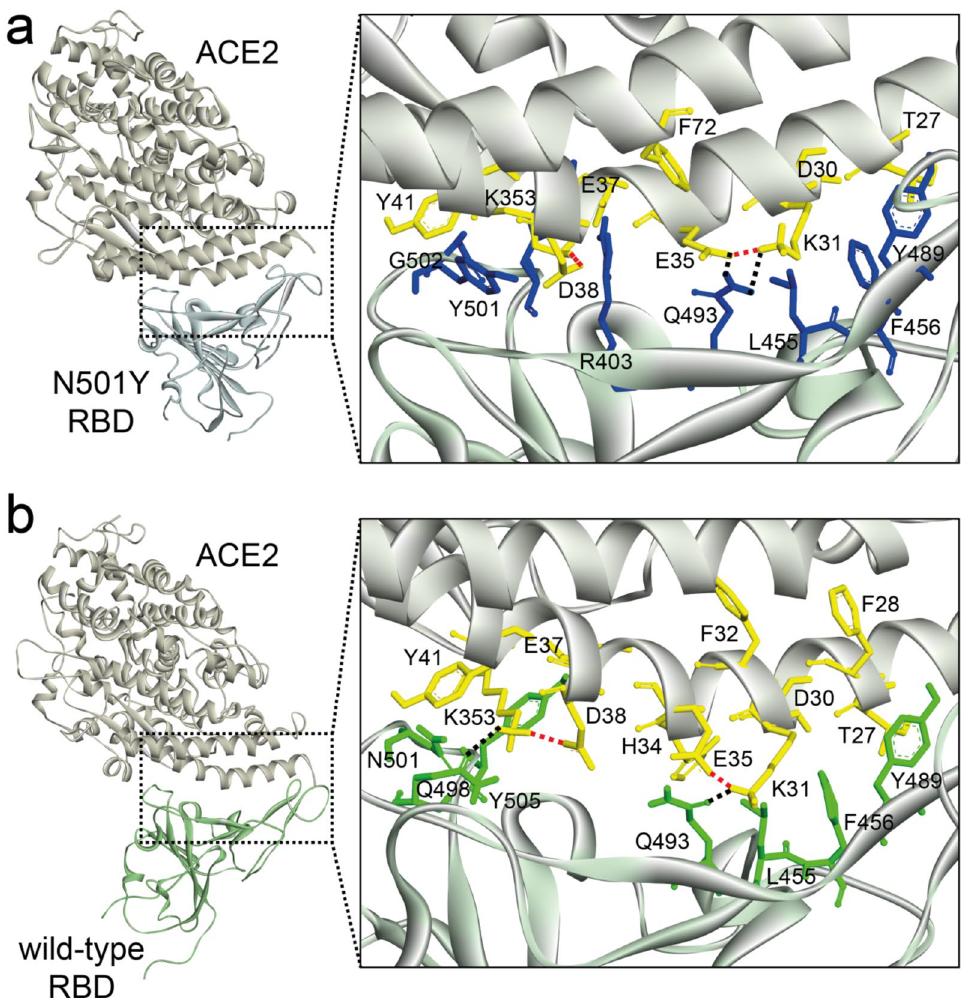
Figure 4. Structural mapping of the binding interface structure of ( a ) N501Y, and ( b ) wild-type complex with ACE2. The structure of RBD is shown in light-yellow ribbon, while ACE2 is in green (wild-type) and pastel- blue (N501Y) ribbon. The close-up of these binding complexes is shown the crucial mutations responsible for high binding interaction (right panel). The interfacial residues of SARS-CoV-2 RBD residues are annotated and shown in green and blue sticks, ACE2 residues are in yellow sticks. The salt bridge presents in red dashed line, while hydrogen bonds are in black dashed line. The figure was drawn by Discovery Studio 2019 Client (Biovia